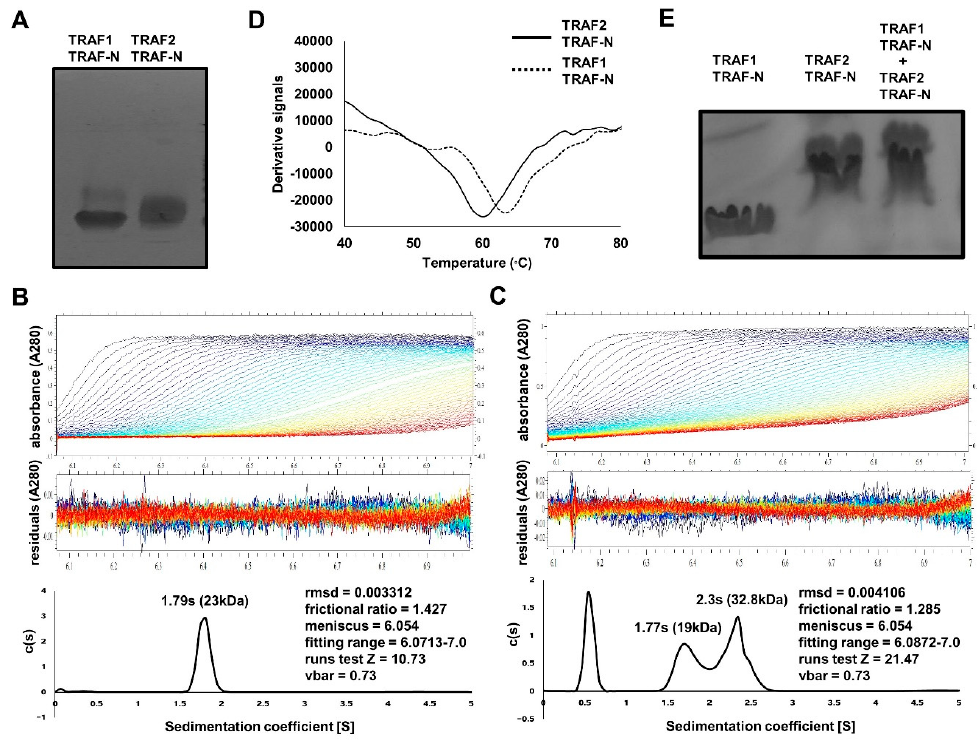
Figure 3. Characterization of TRAF-N domains of TRAF1 and TRAF2. ( A ) Native PAGE with purified TRAF-N domains of TRAF1 and TRAF2; ( B ) Analytical ultracentrifugation analysis of TRAF1